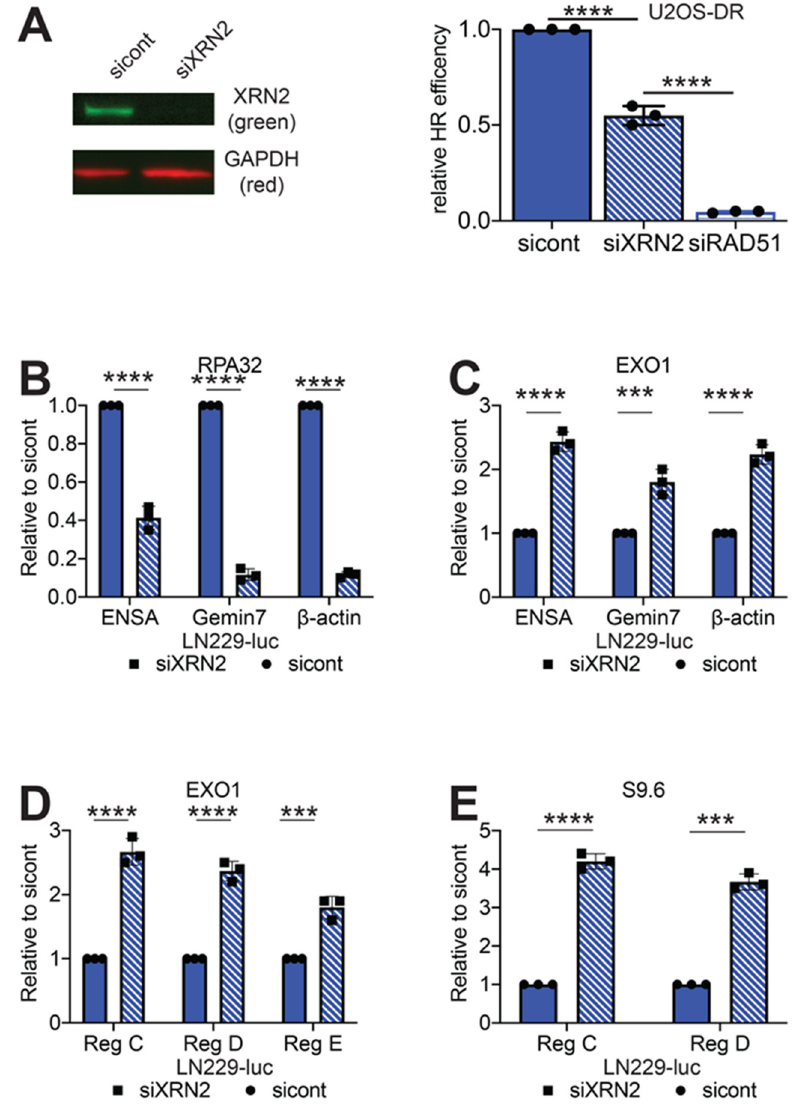
Figure 2. Loss of XRN2 disrupts HR repair. ( A ) Steady state protein levels of XRN2 was measured by Western blot in U2OS-DR reporter cells treated with control or XRN2 siRNAs and efficiency of HR repair in the U2OS-DR cells exposed to control, XRN2 or RAD51 siRNAs and determined by measuring 1000 cells for GFP expression. Chromatin immunoprecipitation / qPCR experiments were performed using ( B ) RPA32, ( C , D ) EXO1 and ( E ) S9.6 antibodies in LN229-luc cells exposed to control or XRN2 siRNAs at the 3’ pause site, Region C (Reg C) Region D (Reg D) and Region E (Reg E). Statistical analysis was done using Student’s t -test. **** = p < 0.0001 and *** = p < 0.001. Detailed information about Western blot can be found at Figure